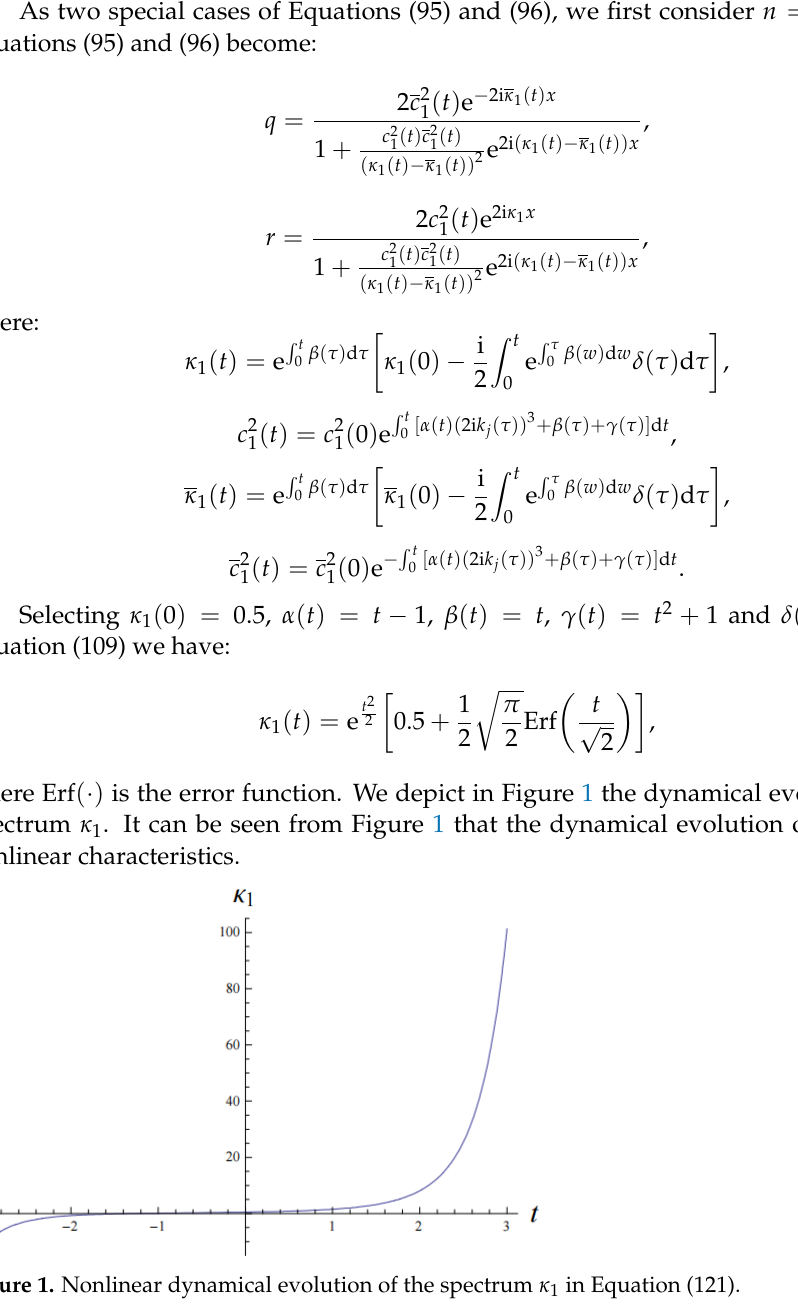
Figure 1. Nonlinear dynamical evolution of the spectrum